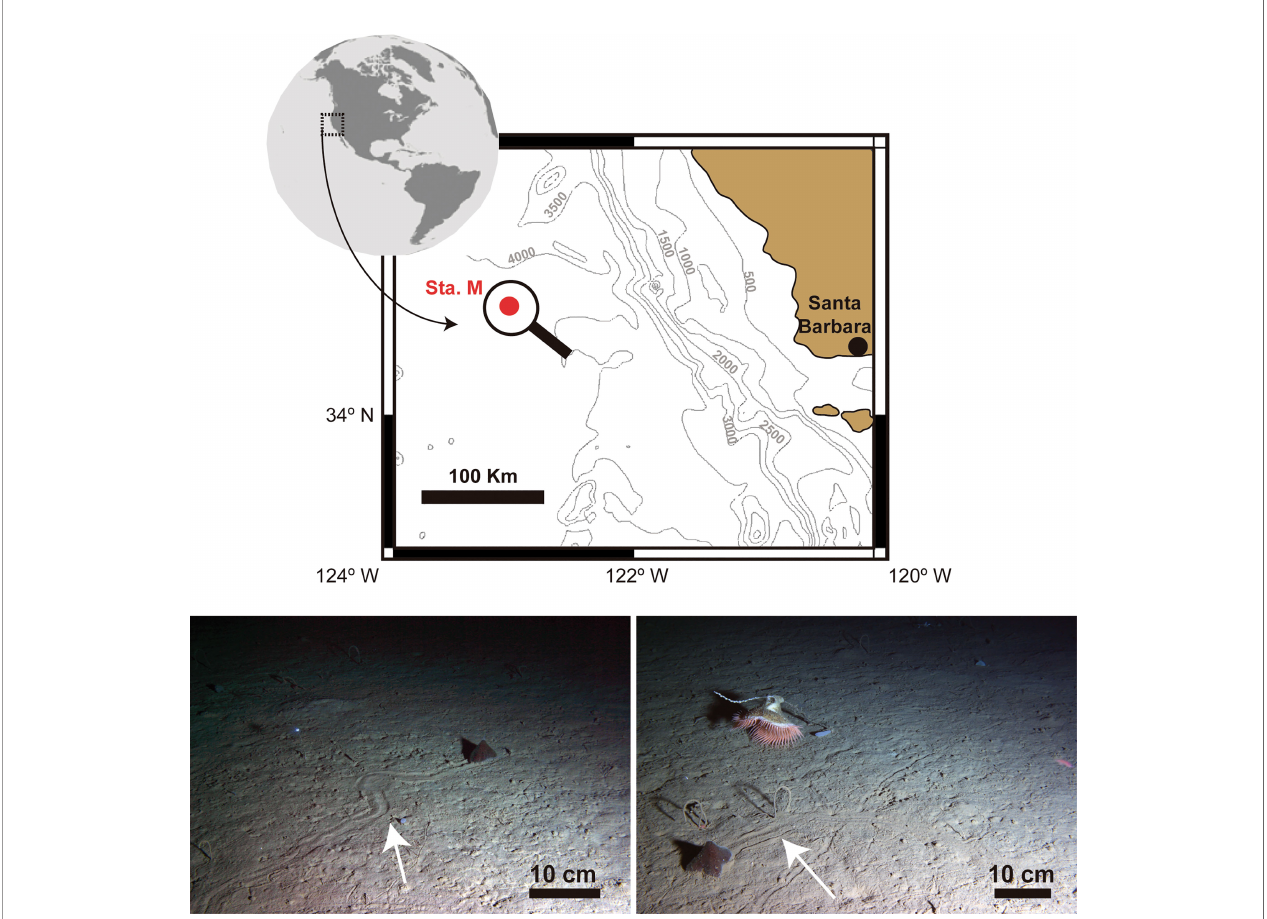
FIGURE 1 | Detailed location of Station M in the Northeast Paci fi c (4000 m) with 500 m contours (slightly modi fi ed from Lampadariou et al., 2020). Image examples (below) of the sea fl oor at Sta. M with E . rostrata specimens (from Jason ROV and R/V New Horizon). The trail left in the sediment by E . rostrata foraging movement is indicated by white